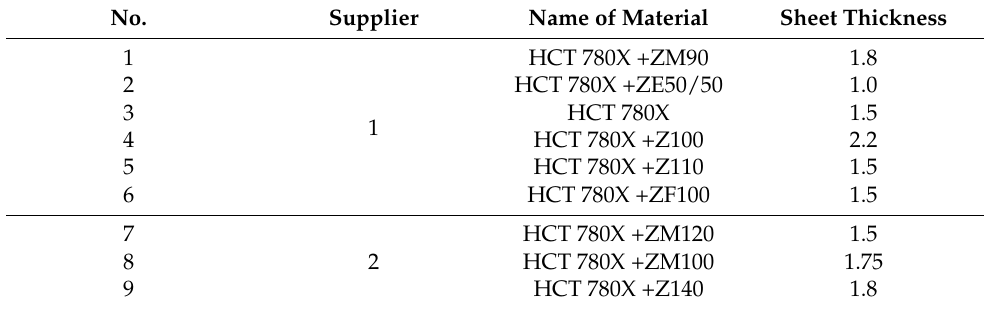
Table 1. Material overview. Name of materials in accordance with DIN EN 10346:2015 and DIN EN 10152:2017.